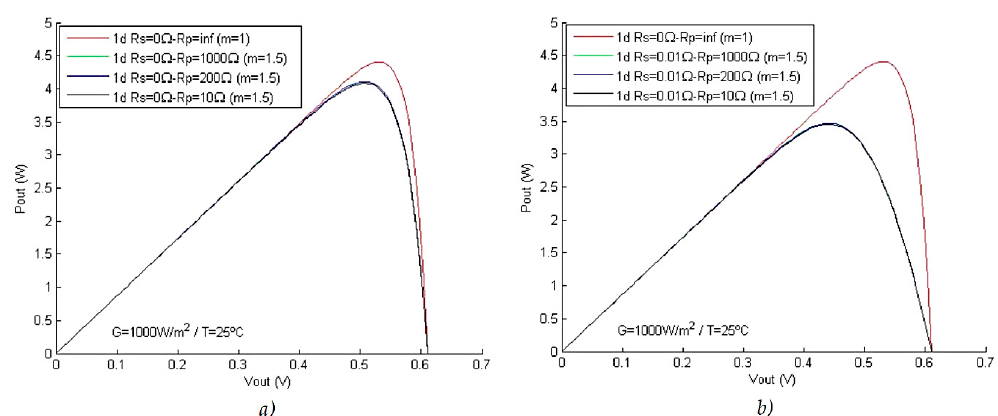
Figure 4. P - V curves as a function of the parallel resistance R p and with R s : ( a ) 0 Ω and ( b ) 10 m Ω ; (STC).